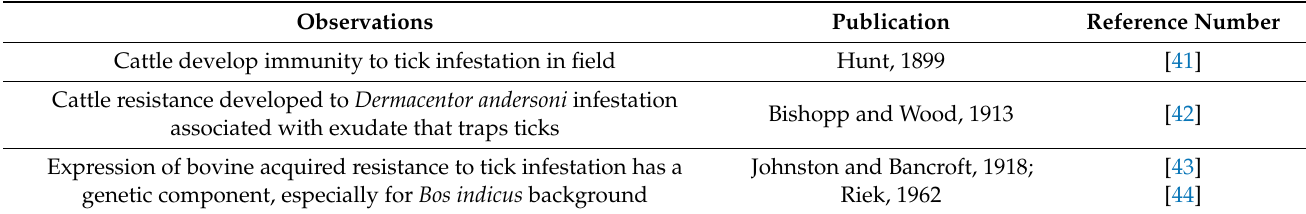
Table 1. Major early observations about bovine resistance to tick